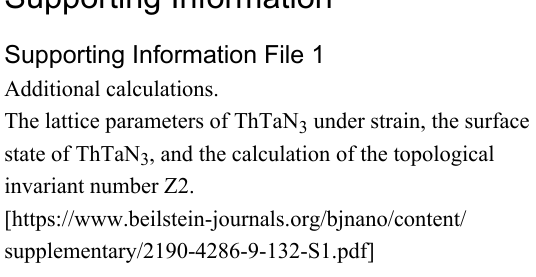
Supporting Information Supporting Information File